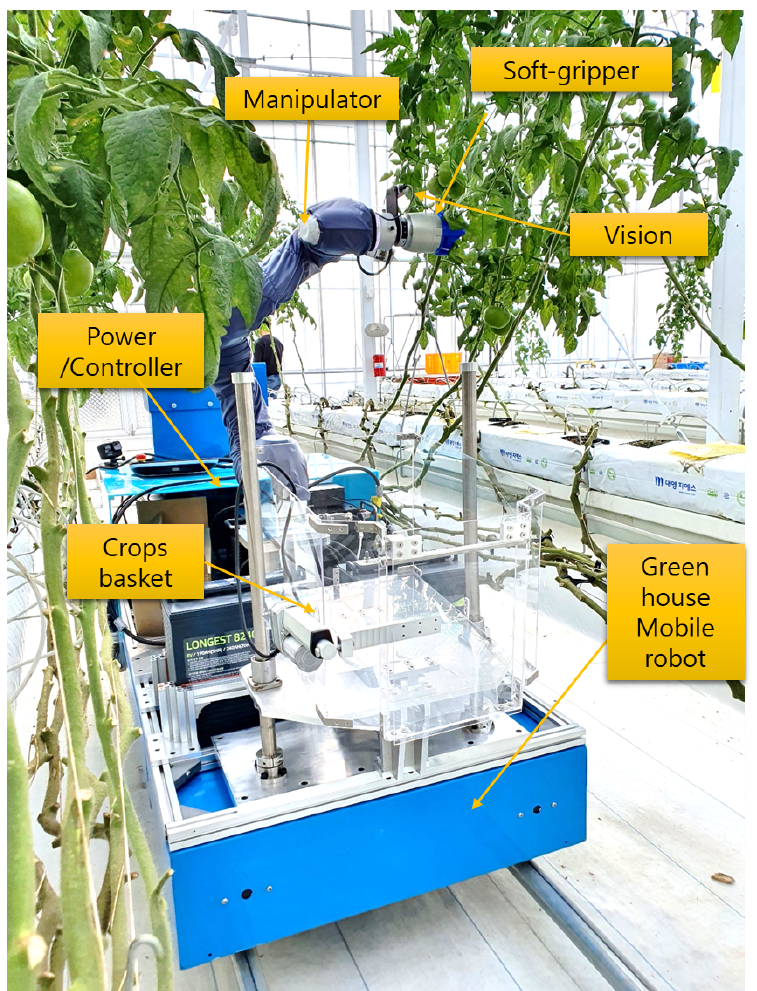
Figure 3. Developed harvesting robot with manipulator.